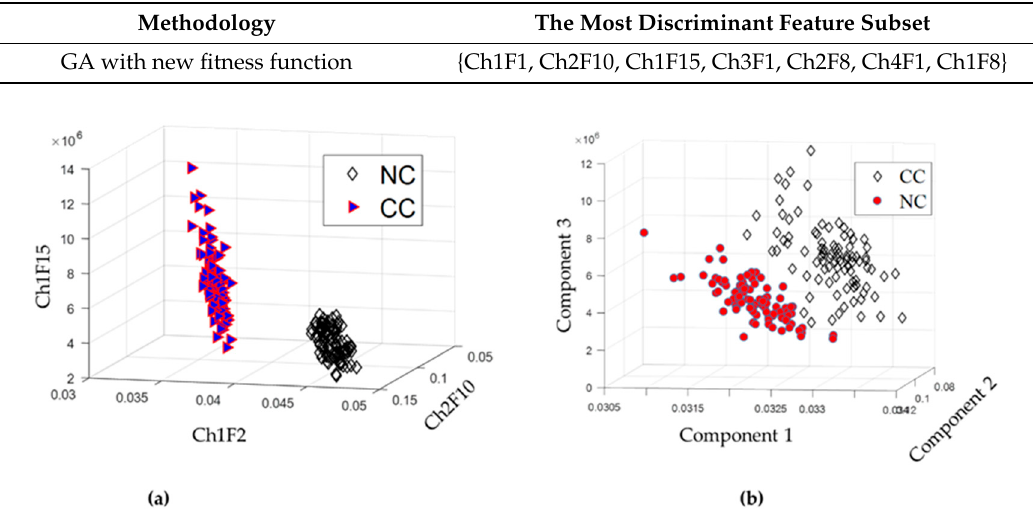
Table 3. Summary of the discriminant feature subset attained by the proposed GA. In this Table, for example, Ch1F1 means feature 1 (i.e., RMS) of Channel 1.